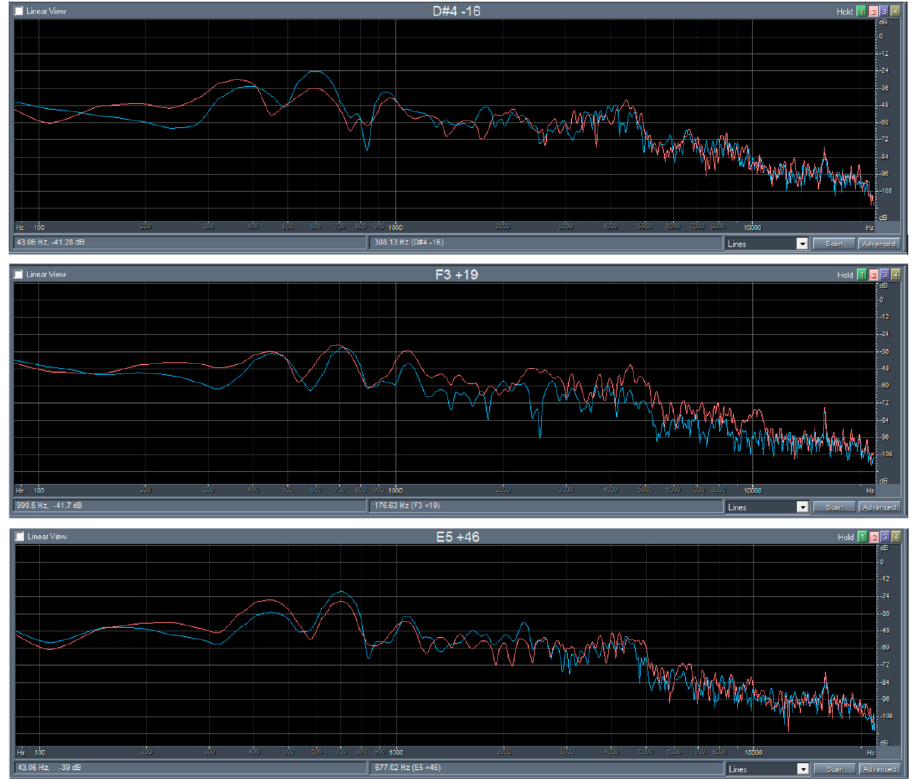
Figure 5. FFT analysis spruce before and after thermal modification at 135 °C, 160 °C and 185 °C.